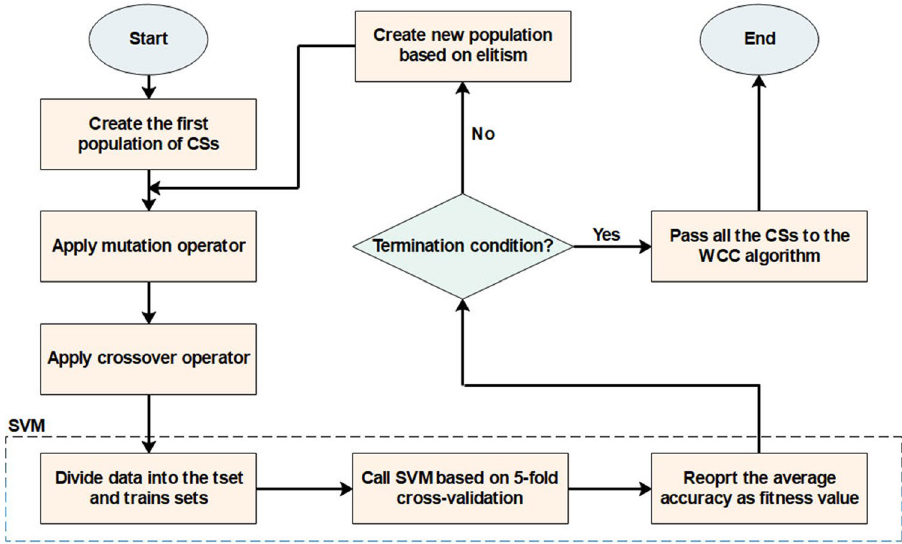
Figure 2. Flowchart of the employed GA. This algorithm begins with several randomly generated potential answers (a subset of the existing features) and applies its operators to produce new CSs, which contain the selected features. To calculate fitness of the CSs, a model is created using SVM, and its accuracy (based on fivefold cross-validation) is reported. Also, to generate new population, elitism method (which generates new population based on the CSs having the higher value of fitness) has been used. CS, candidate solution; GA, genetic algorithm; SVM, support vector